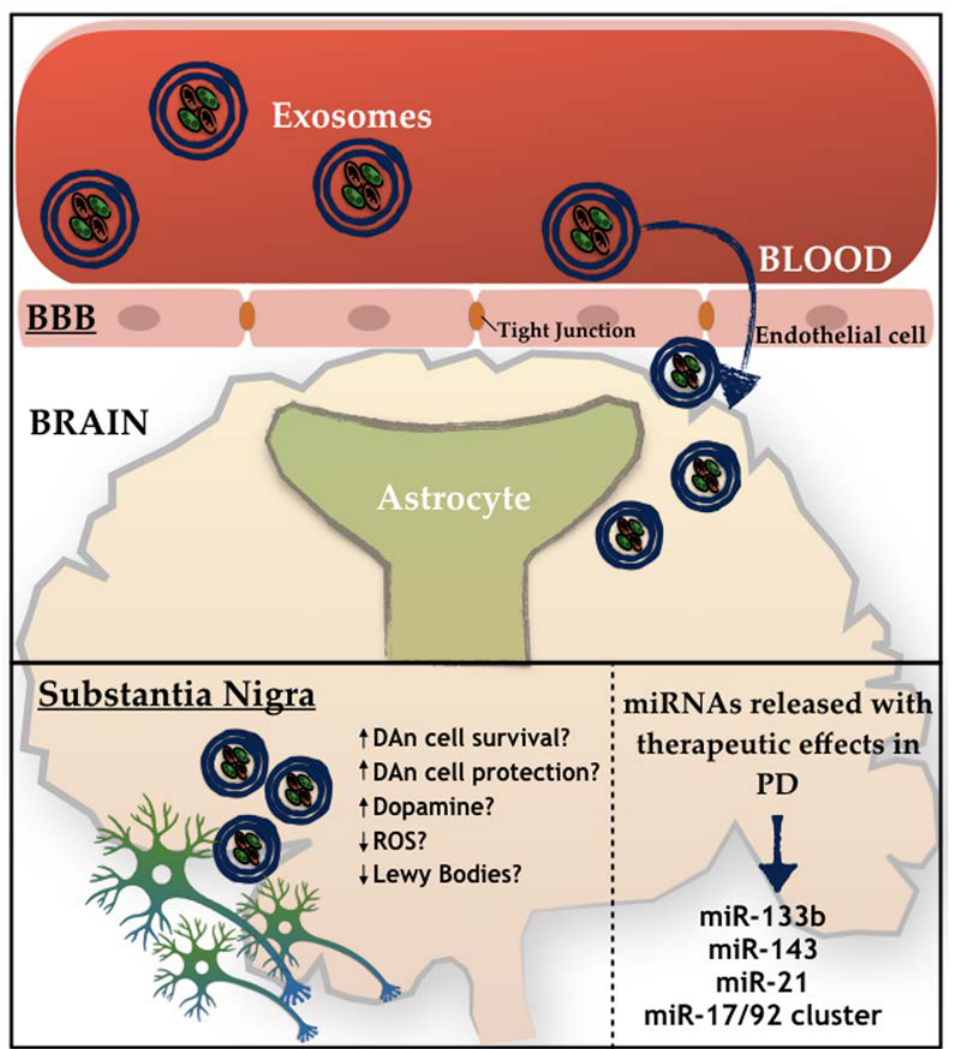
Figure 2. Schematic representation of the active role of exosomes on PD. How exosomes recognize and internalize other cells remains under discussion. Free-floating, adhesion, and antigen recognition have been described as mechanisms of cellular recognition, while soluble and juxtacrine signaling, fusion, phagocytosis, micropinocytosis, and receptor- and raft-mediated endocytosis have been described as mechanisms of exosomal internalization, as described by [75].